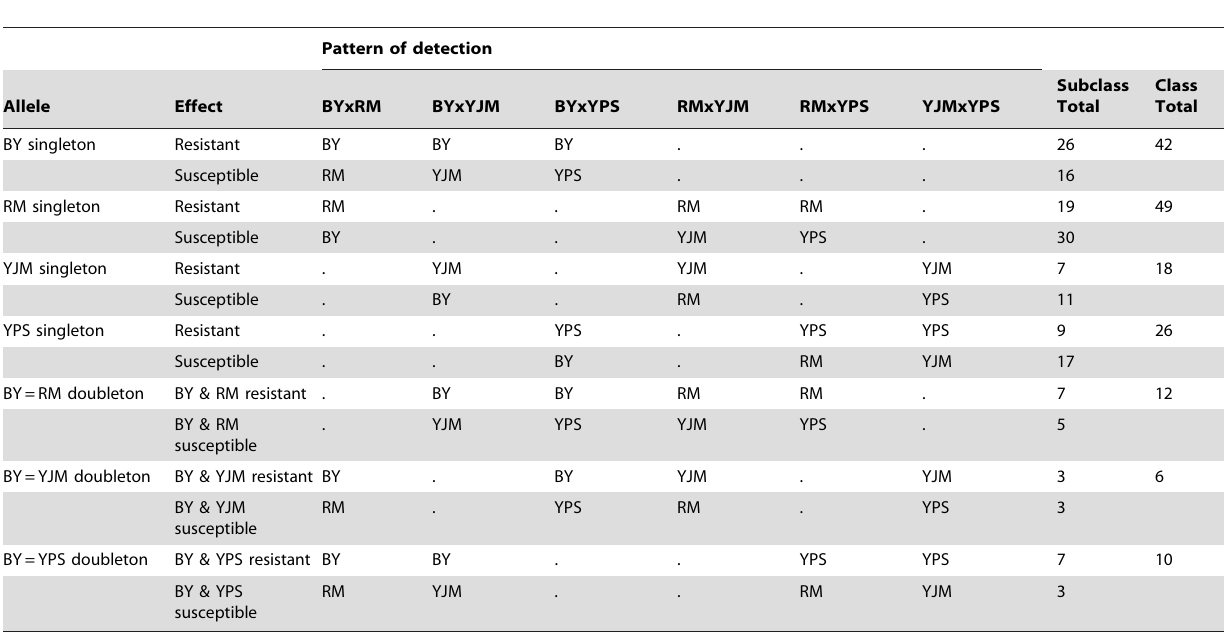
Table 1. Patterns used to identify allelic singletons and allelic doubletons in the X-QTL data, and the number of loci detected with these